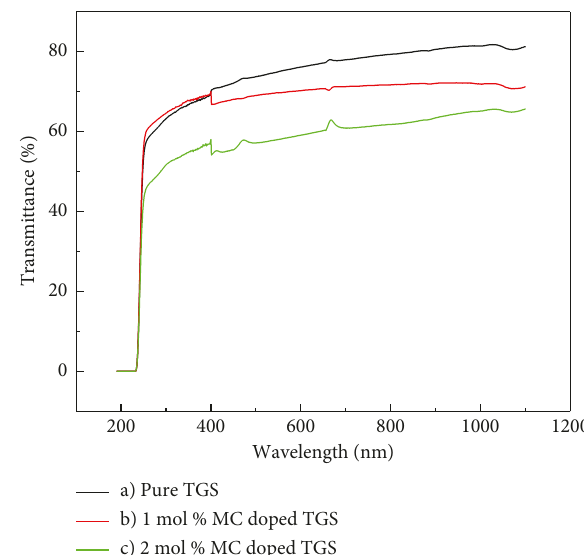
Figure 2: Transmittance versus wavelength for pure and 1 and 2mol% of MgCl 2 -doped TGS